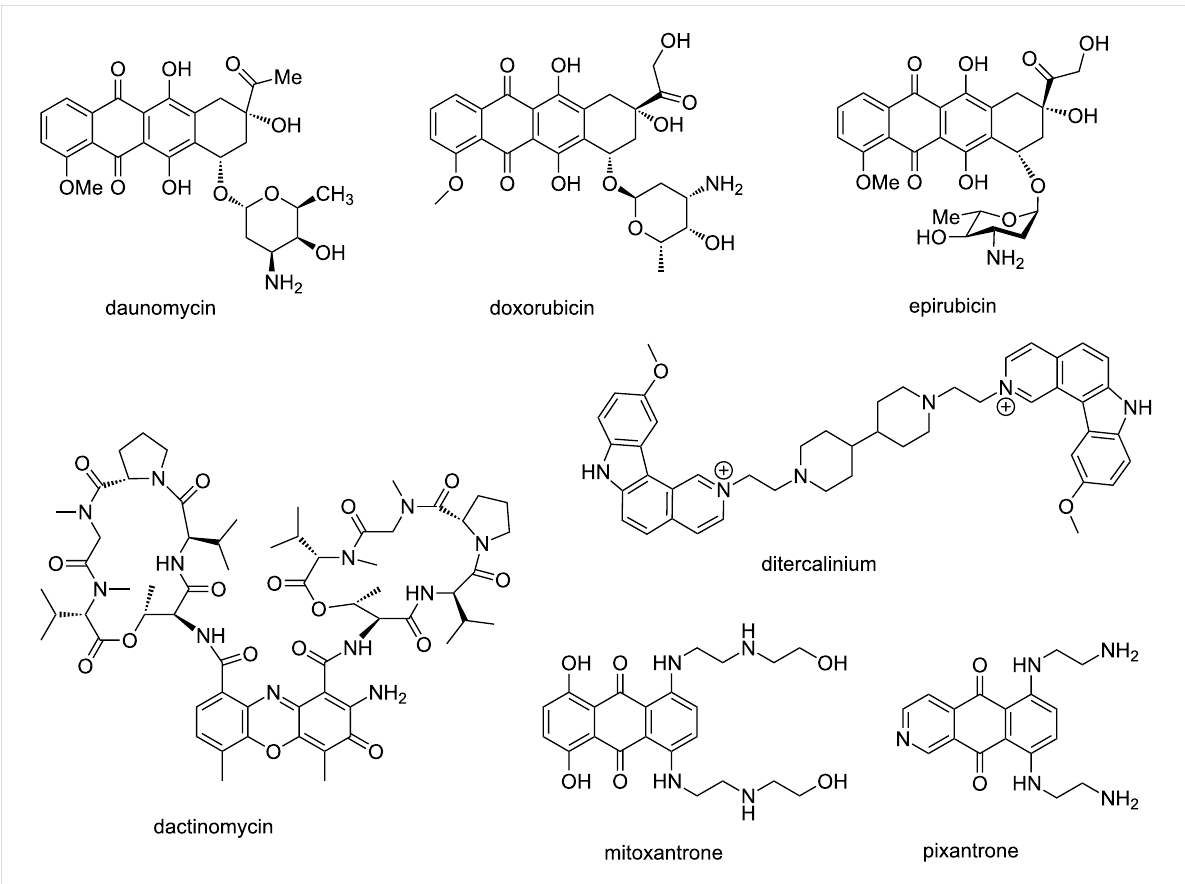
Figure 14: Chemical structures of well-known naturally occurring DNA binding